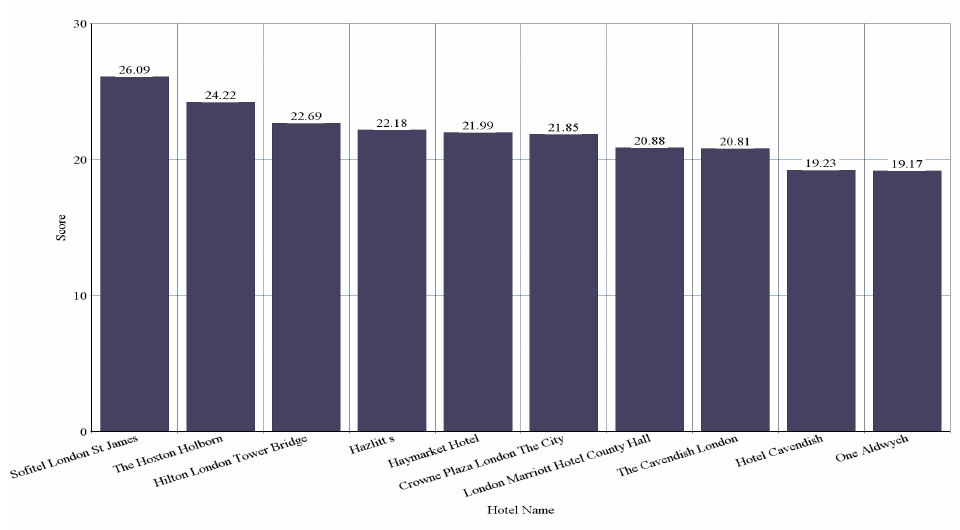
Figure 8. Top-10 Hotel Recommendation Generation by Our System for the 214 Common Hotels by considering the dataset of